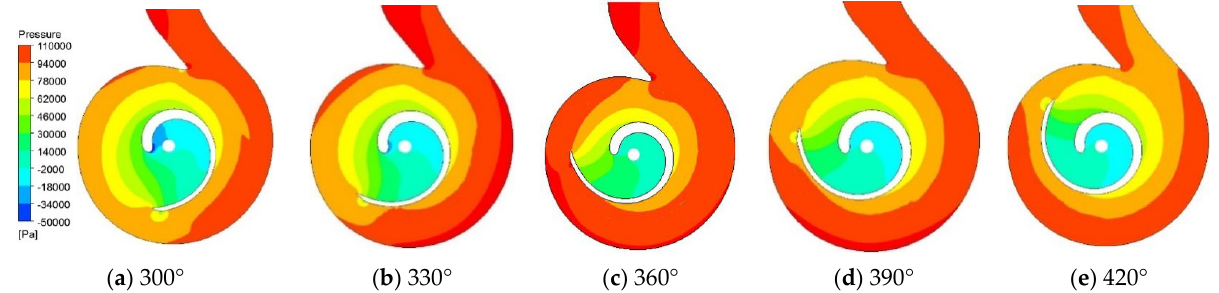
Figure 18. Pressure distribution in the pump under large flow rate conditions (1.4 Q d ).